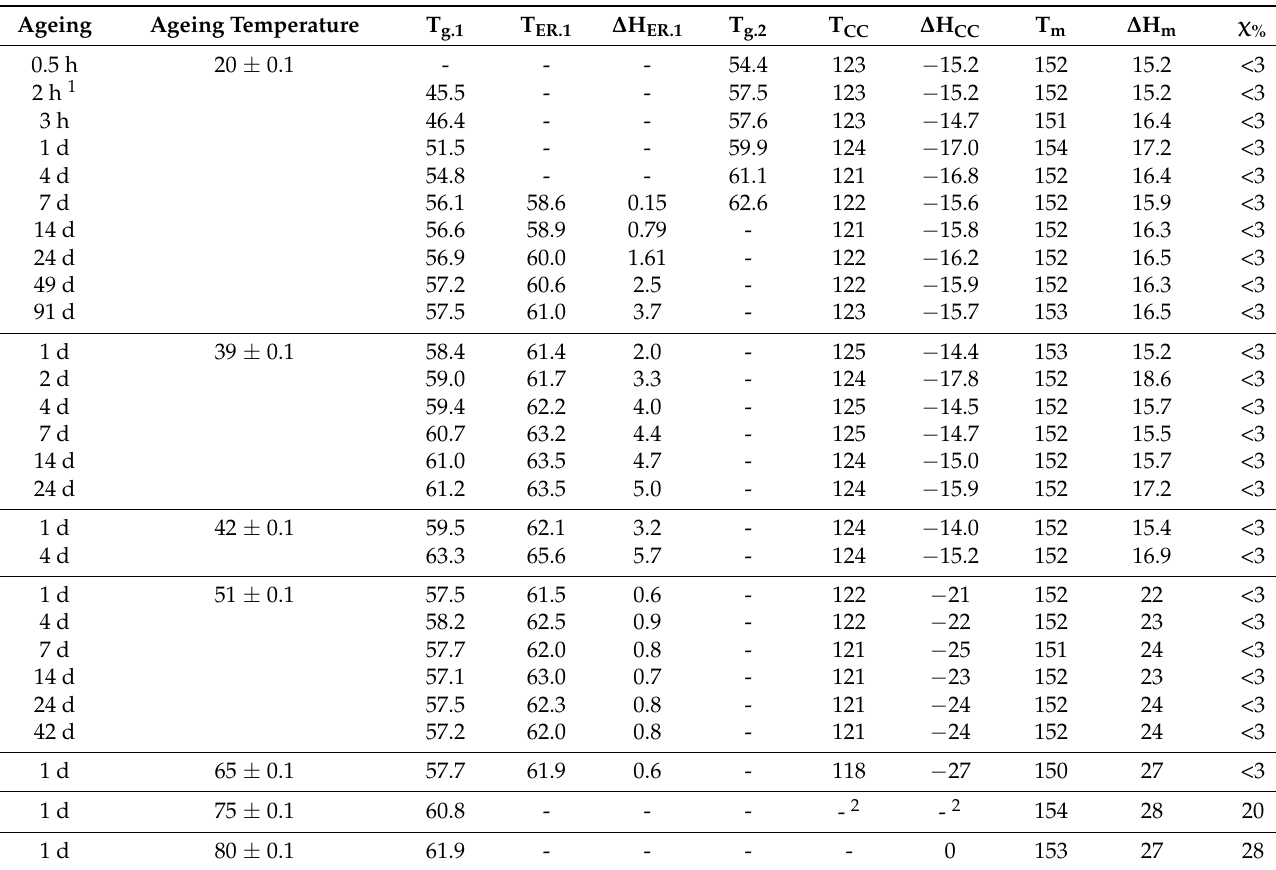
Table 1. Thermal properties of the 1D-printed PLA. All samples were printed at 215 ◦ C. Temperature measured in ◦ C with a ± 0.5 error (except as indicated), enthalpies in J/g with a 3.4% error of total value following Mettler Toledo guidelines, time in hours (h) or days (d) with an error of ± 0.1h. All aged samples at temperatures above 20 ◦ C were aged after 2 h of natural ageing (for example, one day at 39 ◦ C means that the material has been aged 2 h at 20 ◦ C and one day at 39 ◦ C), crystallinity in percentage (%) with an error of ± 1. Positive enthalpy changes indicate that the material absorbs energy, following the IUPAC convention. T g.1 and T g2 : first and second glass transition on the DSC during heating; T ER : enthalpic relaxation temperature; ∆ H ER : enthalpy of enthalpic relaxation; T CC : cold crystallisation temperature; ∆ H CC : enthalpy of cold crystallisation; T m : melting